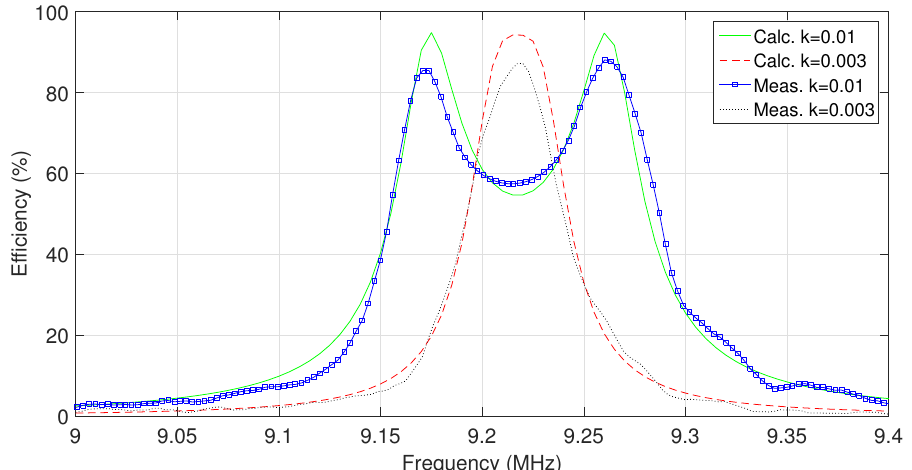
Figure 12. Comparison between the measured and calculated maximum efficiency and frequency pattern for the modified circuit with additional coils. The results show close similarity of calculated and measured